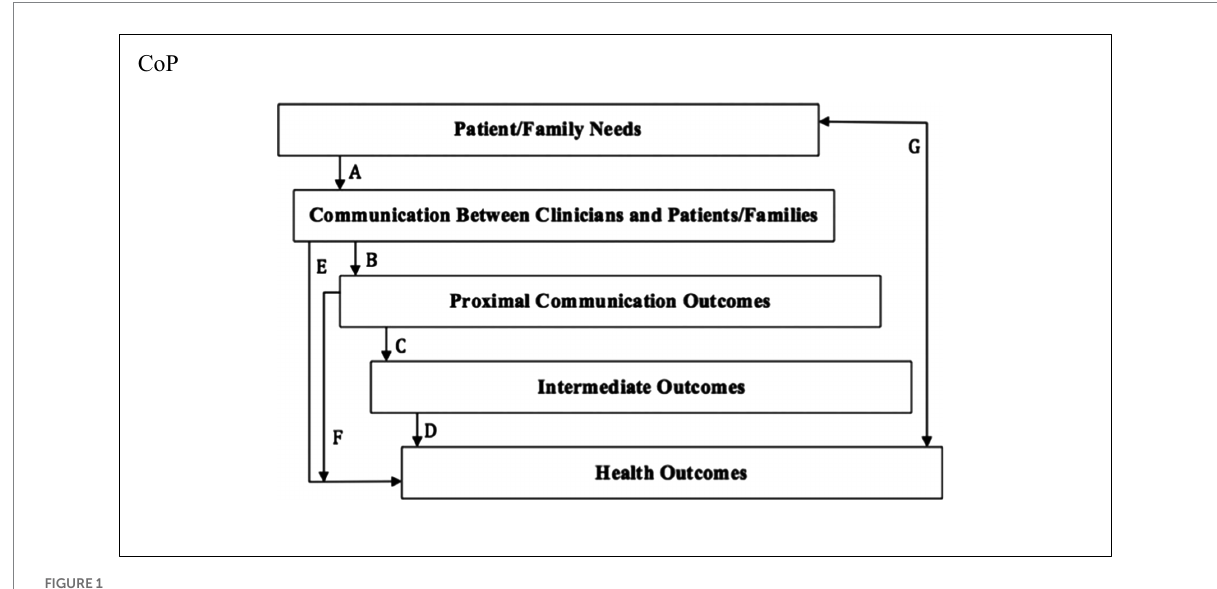
FIGURE 1 The conceptualisation of CoP in the context of patient-centred care concept [adapted from Epstein and Street (2007) as cited in Hong and Oh